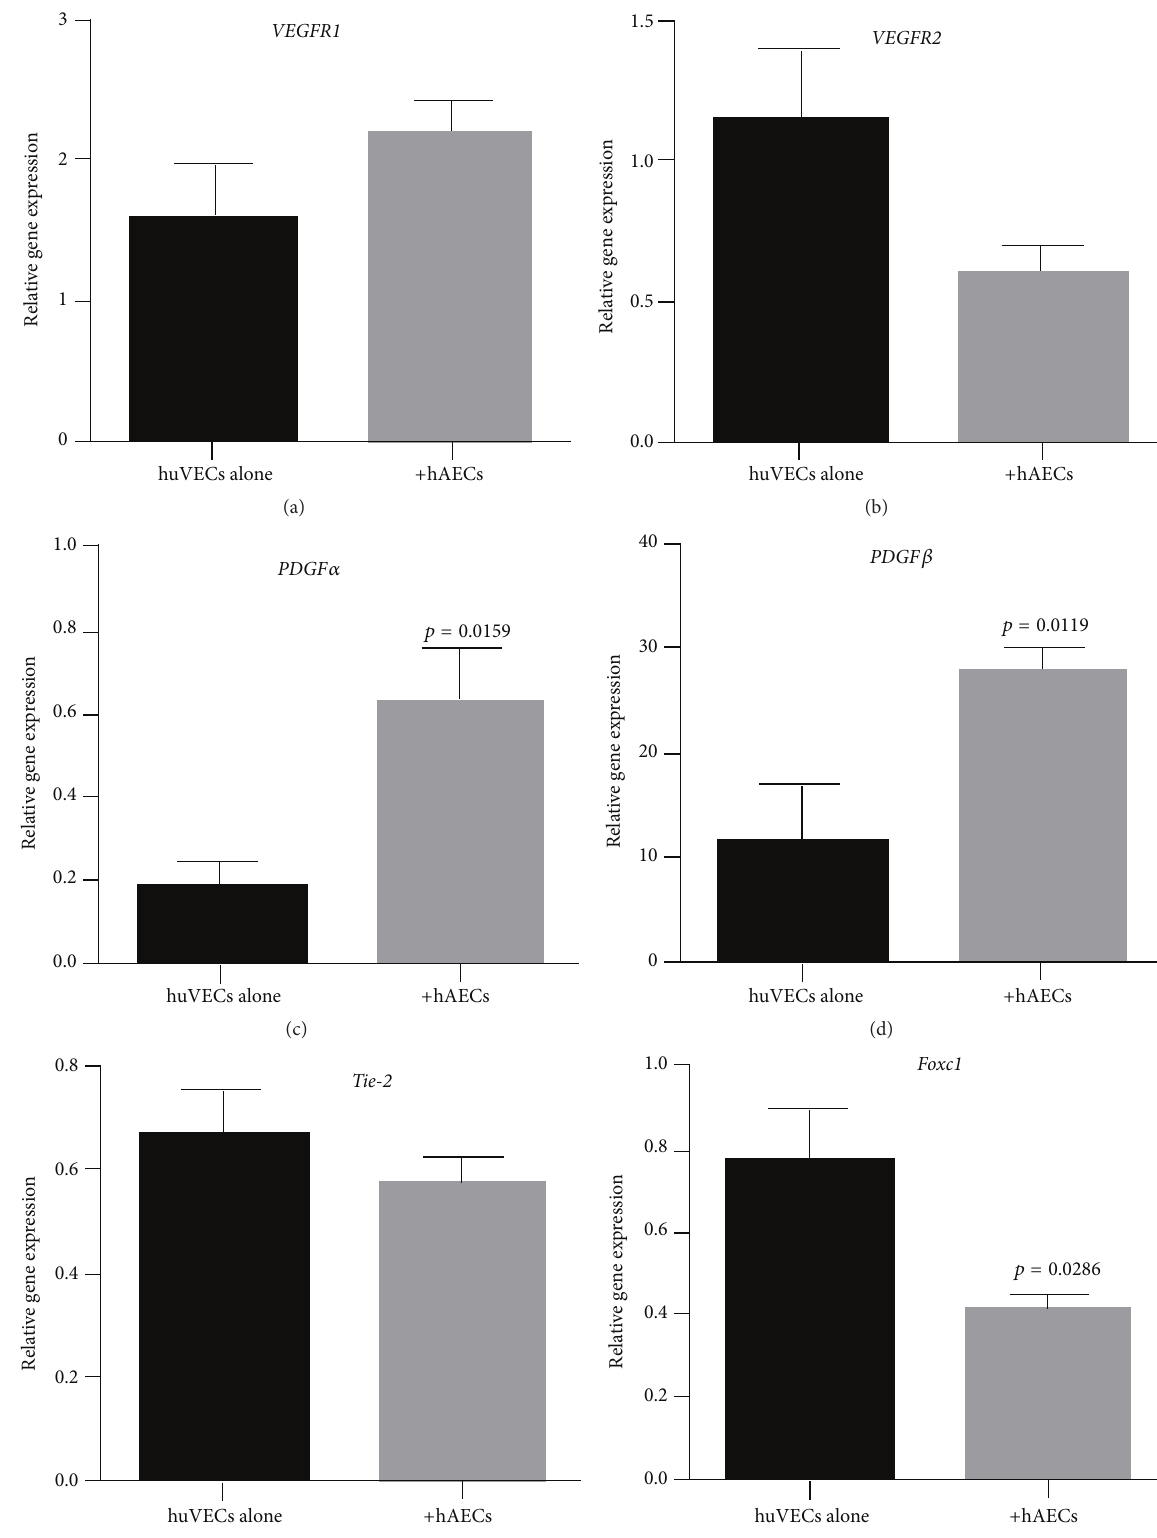
Figure 5: Gene expression of angiogenic factors in huVECs cocultured with preterm hAECs in the presence of TNF 𝛼 and IFN 𝛾 . ((a), (b), and (e)) There was no change of gene expression of VEGFR1 , VEGFR2 , and Tie-2 . ((c), (d), and (f)) While gene expression of FOXC1 was also significantly reduced ( 𝑝 = 0.0286 ), gene expression of PDGFR 𝛼 and 𝛽 was significantly increased ( 𝑝 = 0.0159 and 𝑝 = 0.0119 ,